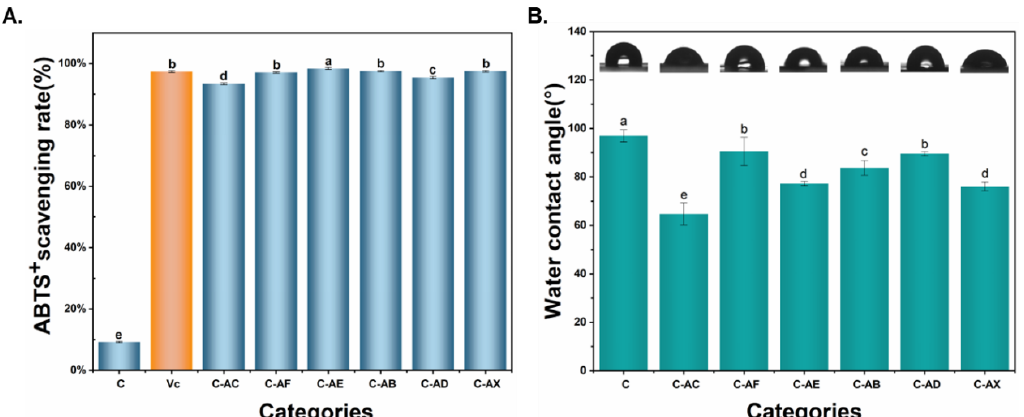
Figure 5. The ABTS+ scavenging rate ( A ) and WCA ( B ) of the collagen-based films. C (collagen film); C-AC (collagen with none-modified APL film); C-AF (collagen with C. echinulate FR3-modified APL film); C-AE (collagen with G. lucidum EN2-modified APL film); C-AB (collagen with P. ostreatus BP3- modified APL film); C-AD (collagen with S. commune DS1-modified APL film); C-AX (collagen with Xylariaceae sp. XY-modified APL film). For the comparison between different biological modifications, different lowercase letters represent significant differences ( p < 0.05).